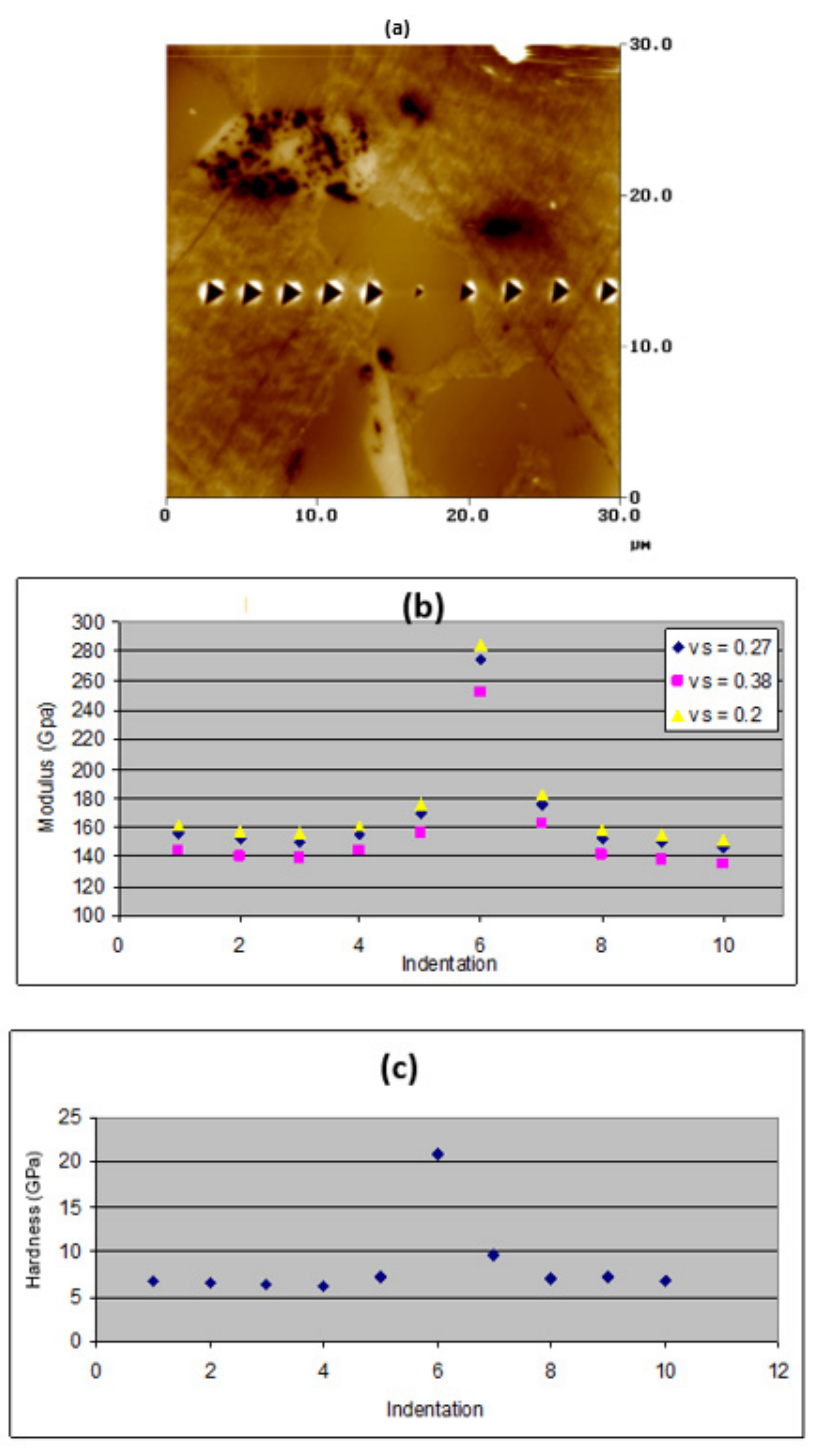
Figure 11. Data for ( b ) modulus and ( c ) hardness of Nb ss and Nb 5 Si 3 in NV1-HT for ( a ) a nanoinden- tation line scan crossing a Nb 5 Si 3 grain located between two Nb ss grains.